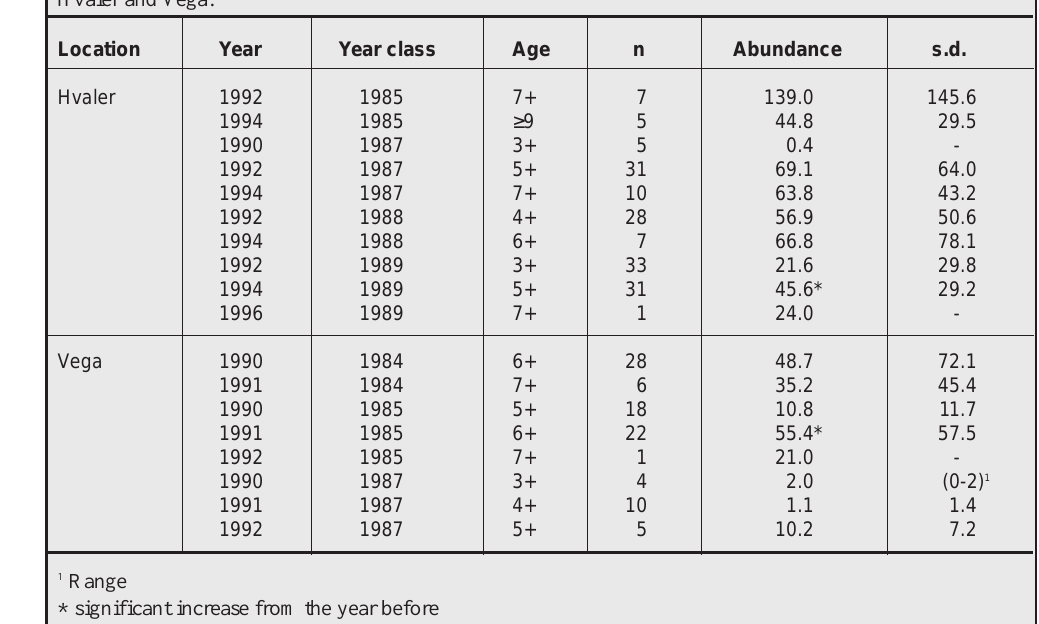
Fig. 4 Frequencies of food items in the stom- achs of sculpins from Hvaler (n=40) and Vega